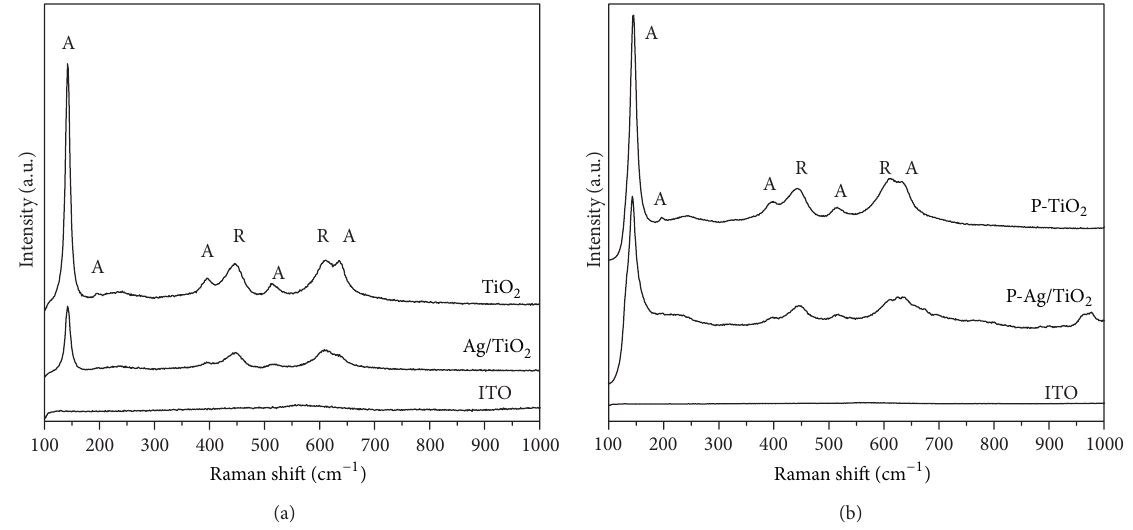
Figure 2: Raman spectra for (a) ITO, Ag/TiO 2 , and TiO 2 ; (b) ITO, P-Ag/TiO 2 , and P-TiO 2 .